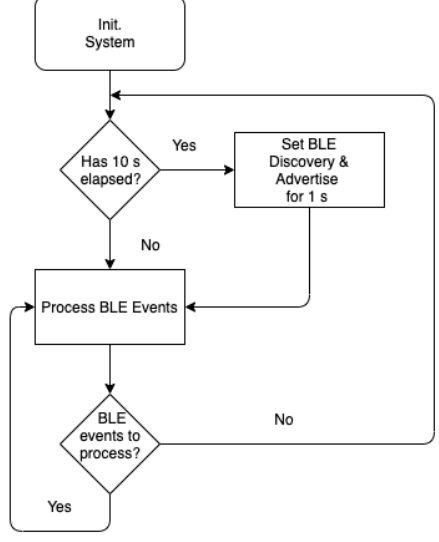
Figure 3. Base case flow